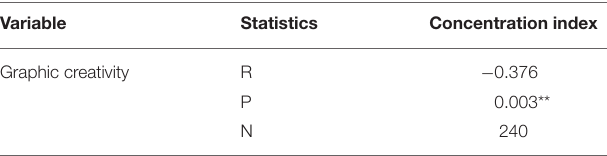
TABLE 4 | Correlation between graphic creativity and concentration index in students an above-average IQ.